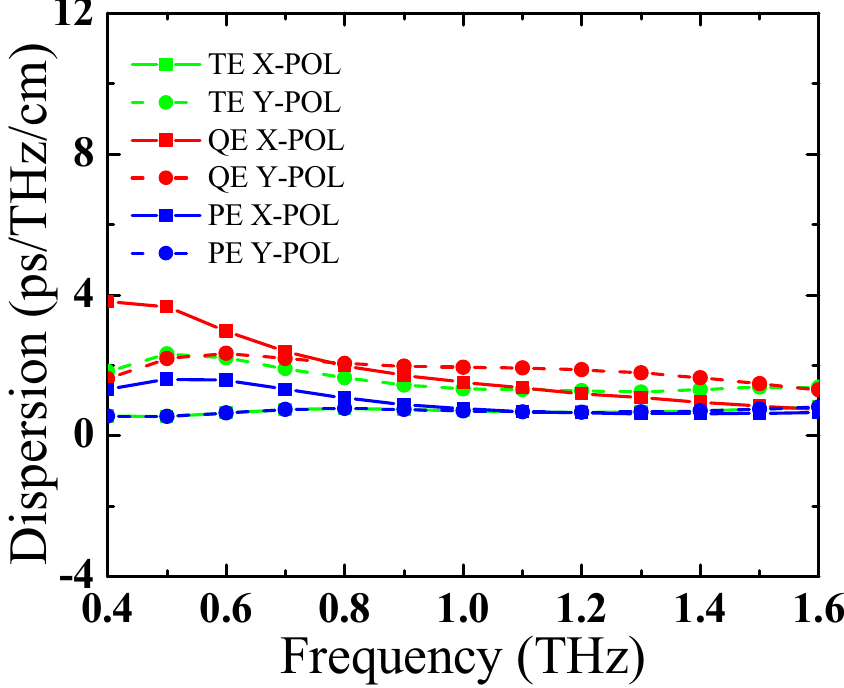
Figure 4. Dispersion profile of the XP and YP modes for the TE, QE, and PE designs. Confinement loss determines how well light is bounded within the core region. Confinement